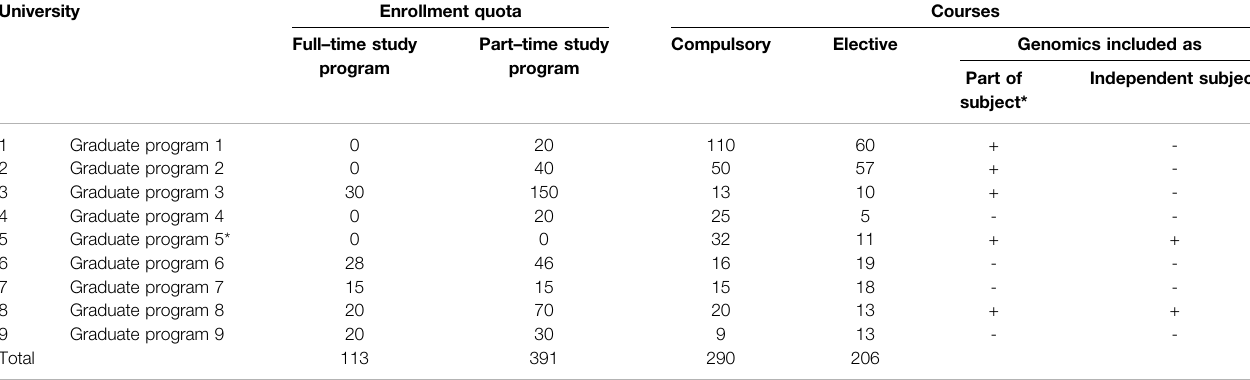
TABLE 3 | Curriculum for Graduate studies in nursing (academic year 2020/2021) in